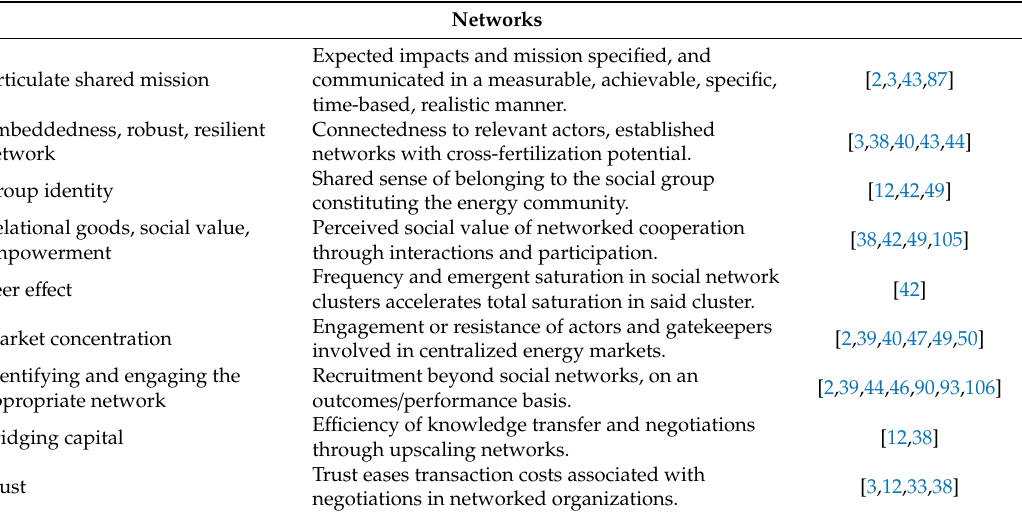
Table 8. Network-bound progression factors.